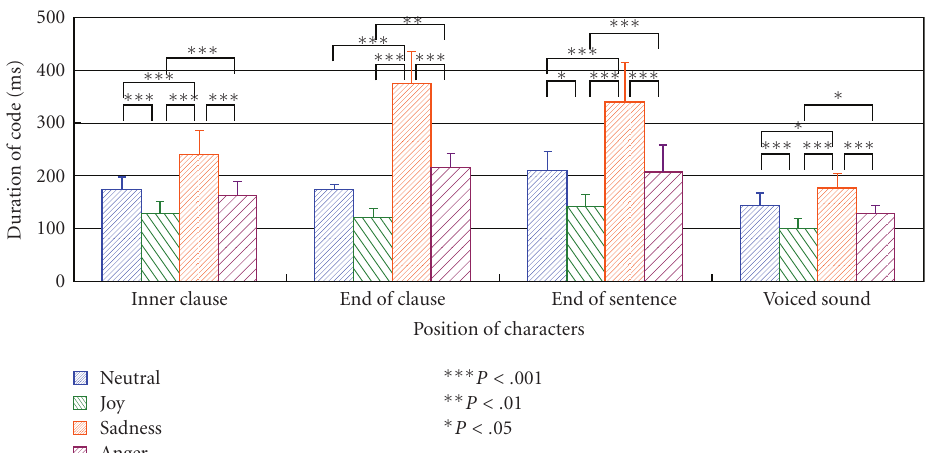
Figure 13: Mean of duration of code as a function of emotions and position of characters for two-handed Finger Braille (error bars represent standard deviations).